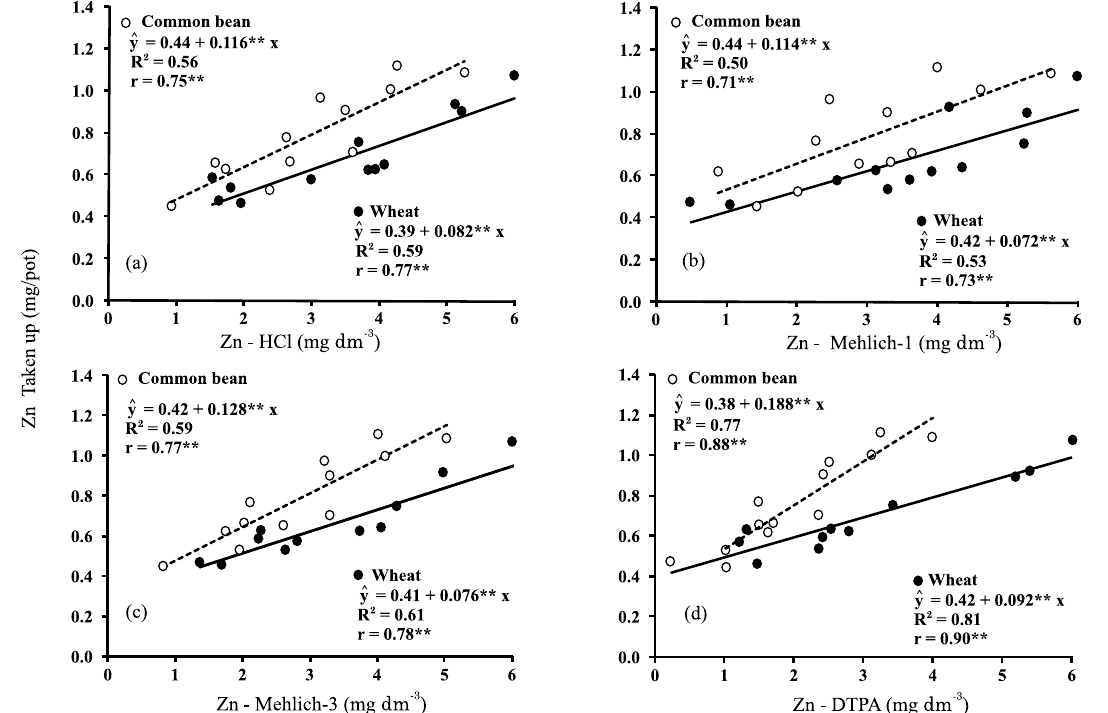
Figure 2. Relationship between the Zn contents extracted from the soil by HCl – (a), Mehlich-1 – (b), Mehlich- 3 – (c) and DTPA (d) and the quantity accumulated in wheat ( ) and common bean ( ) plants, in the first and second planting period, respectively. *: p < 0.05. **: p < 0.01. (n =